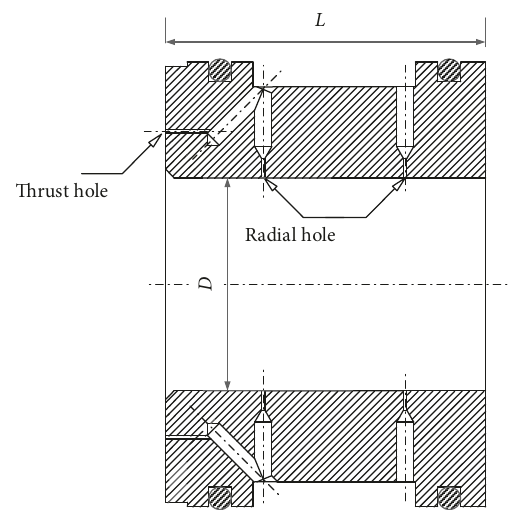
Figure 2: Structure diagram of radial-thrust hybrid gas bearing. Table 1: : Main structural sizes for